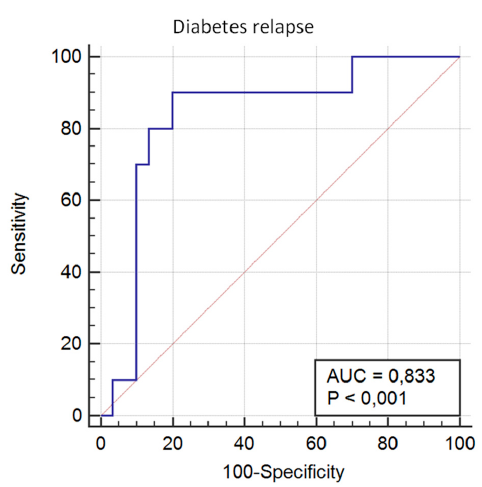
Figure 4. The predictive capacity of the genetic score for T2D relapse after 5 years’